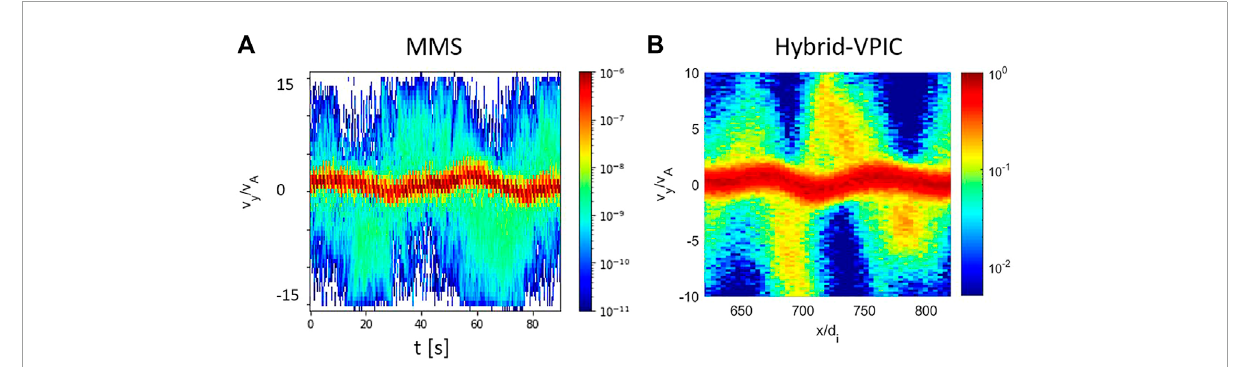
FIGURE 4 Ion velocity distributions in v y from (A) the MMS event displayed in Figure 1 in an interval starting near time 01:05 and (B) from the hybrid PIC simulation with warm beam ( v